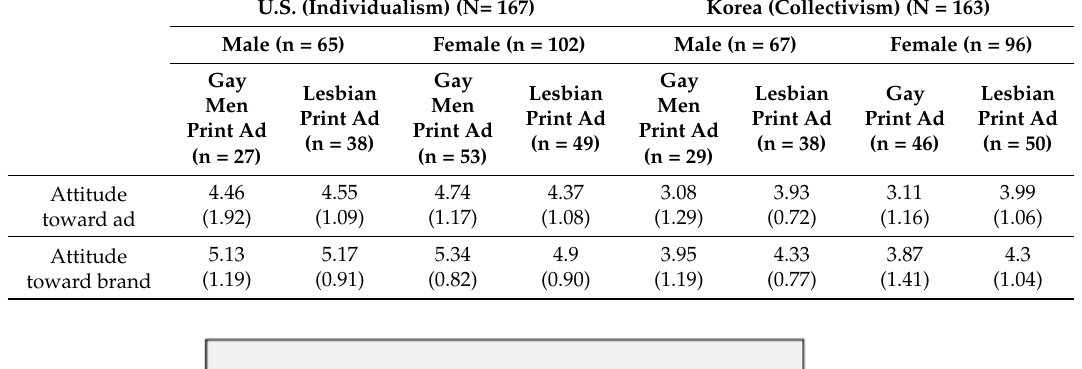
Table 4. Subjects’ Means and Standard Deviations for Ad Evaluation, and Brand Evaluation.